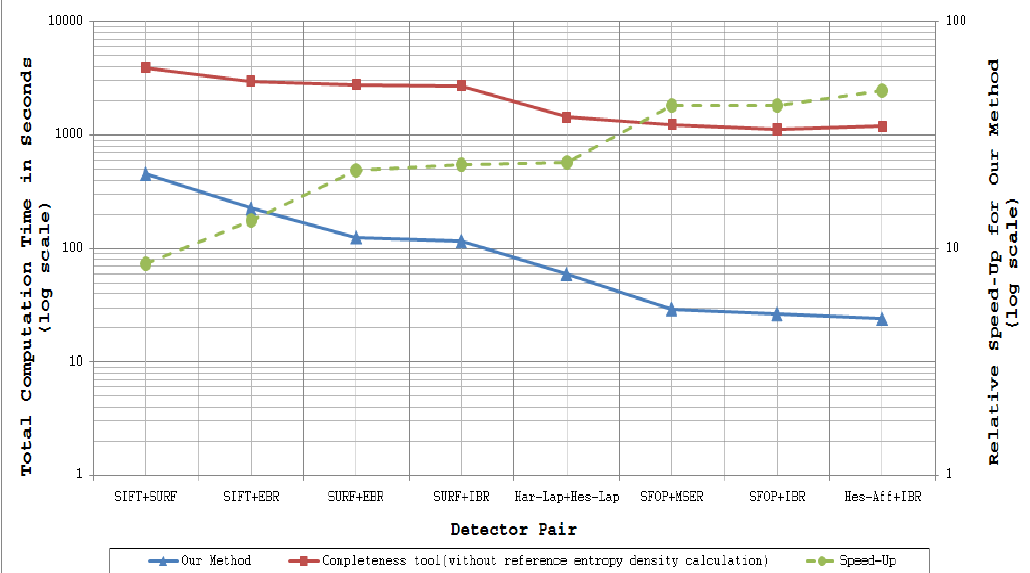
Figure 12. Timing analysis of the proposed mutual coverage method and the Completeness tool [15] for 48 images of the Oxford Datatsets